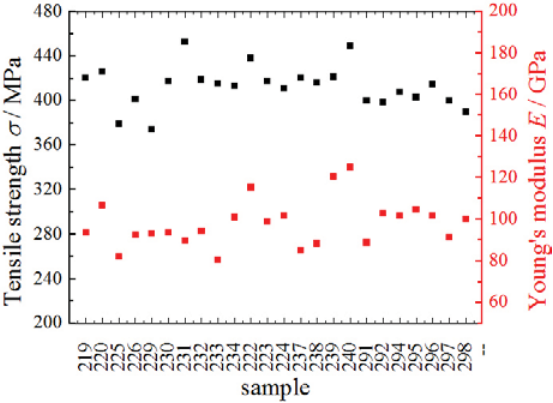
Figure 7. Graphical presentation of tensile strengths and Young’s modulus values of cold rolled Cu tapes.